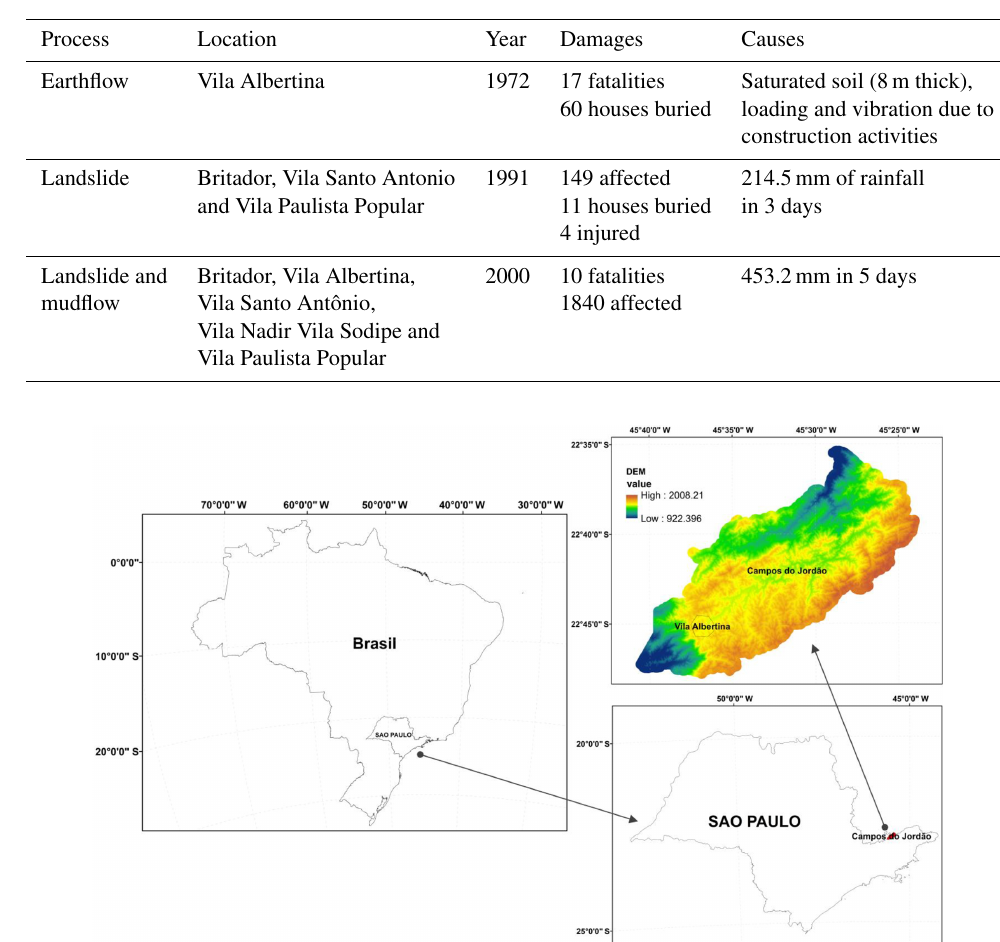
tive behaviour to sudden human interventions that alter their original equilibrium conditions have conditioned the slopes stability in the urban area of the municipality of Campos do Jordão (Ogura et al.,